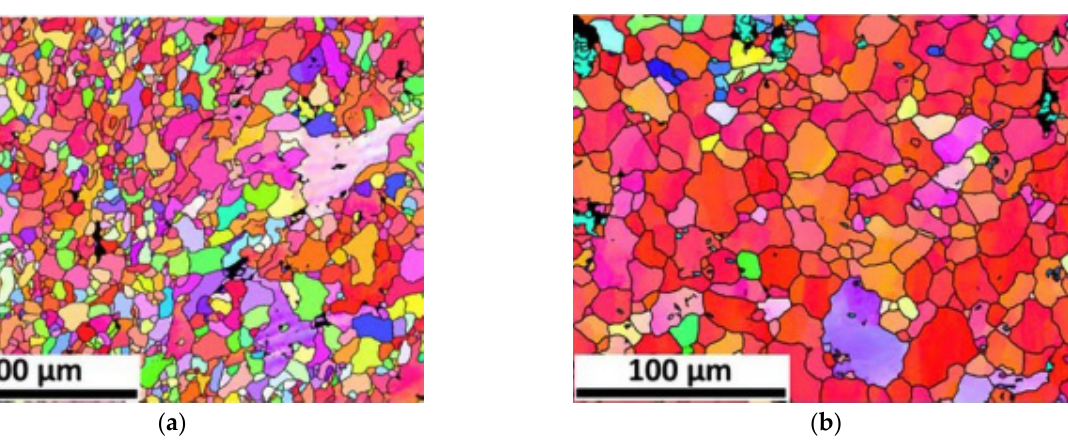
Figure 9. The grain evolution of AZ31B Mg during AFSD process [28]. ( a ) Initial feedstock (grain size: 11 ± 3 μ m). ( b ) After deposition (grain size: 18 ± 3 μ m).